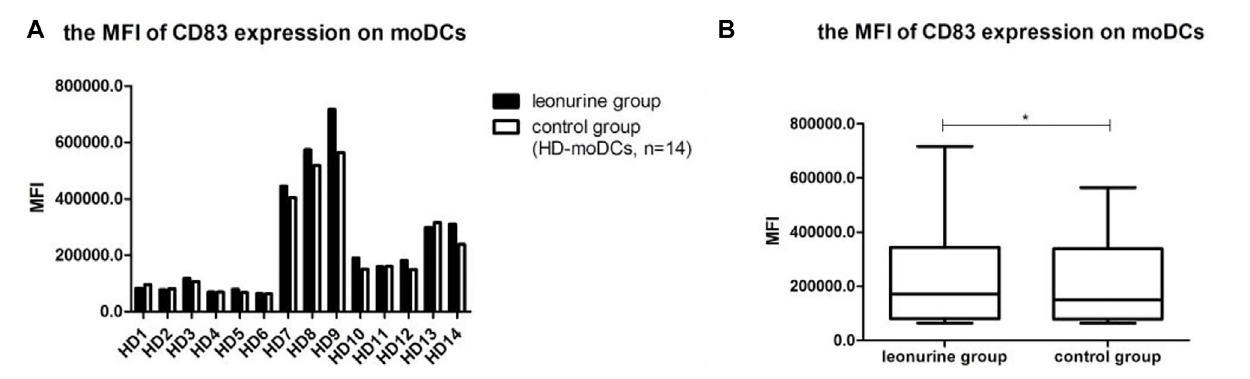
FIGURE 6 The MFI of CD83 expression on moDCs between the leonurine group and the control group (HD-moDCs, n = 14). (A) The graph shows the MFI of CD83 expression on moDCs between the leonurine group and the control group for each HD. (B) The boxplot shows that when moDCs derived from all 14 HDs were analyzed together, theMFI of CD83 expression on moDCs was signi fi cantly higher in theleonurine group than in thecontrol group (2.41 × 10 5 ± 2.06 × 10 5 vs. 2.14 × 10 5 ± 1.71 × 10 5 , p = 0.042, paired-sample t -test).